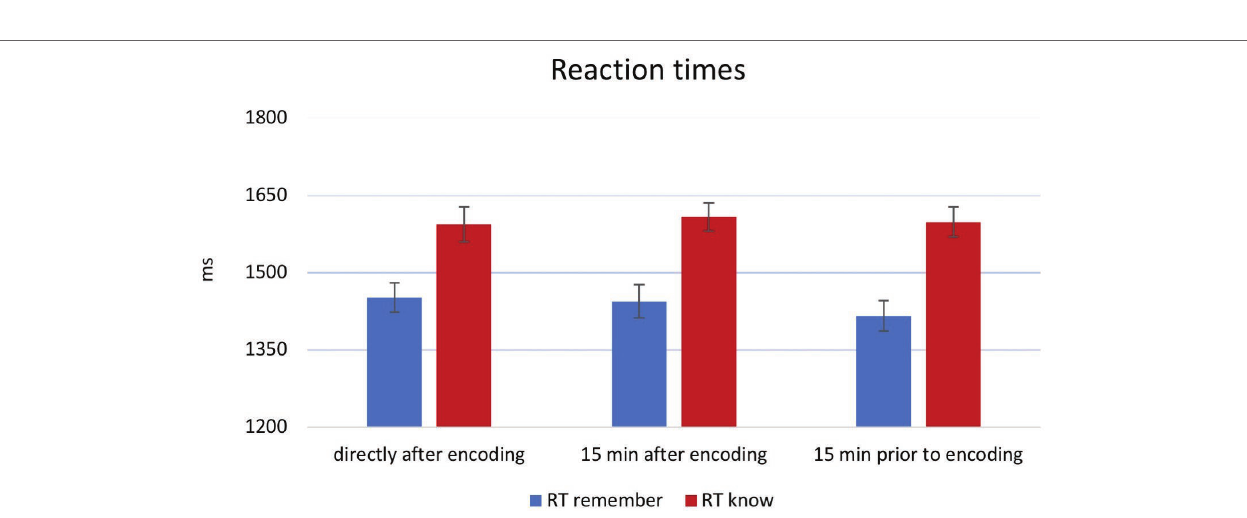
FIGURE 2 | Recognition memory performance. Corrected hit rate (cHR) for remember and know for all three experiments. Error bars indicate ±1 standard error of the mean (SEM).